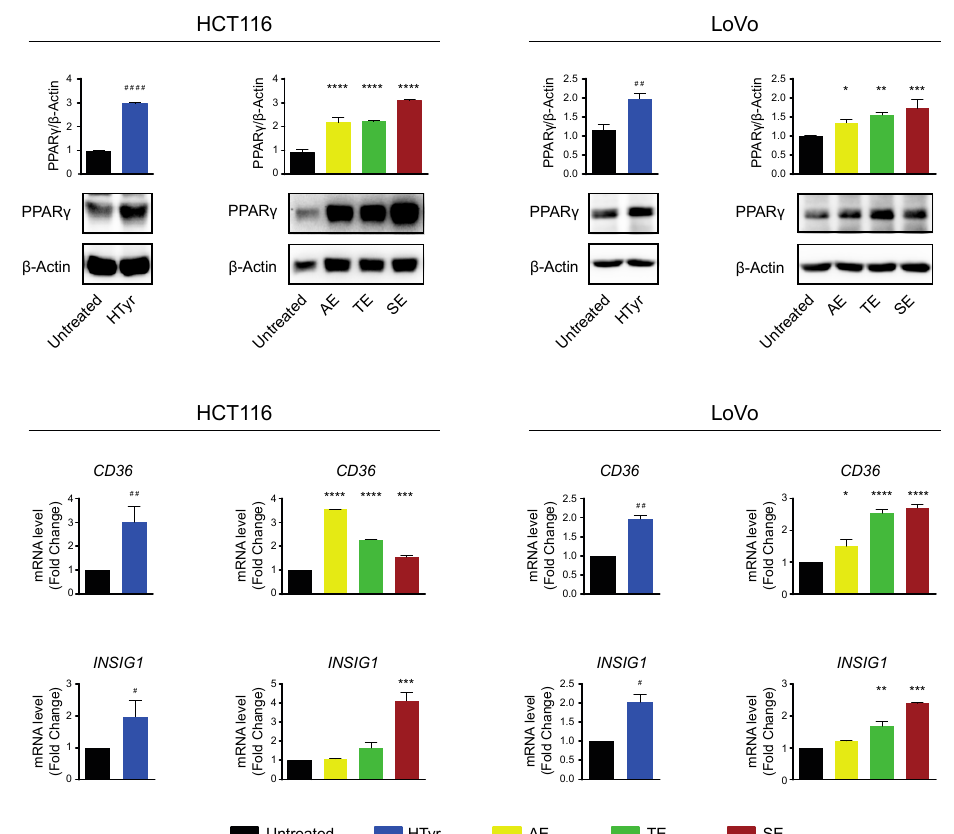
Figure 8. Hydroxytyrosol and the OPWPs extracts stimulate PPAR γ and its target genes in colorectal cancer cells: ( A ) Western blot analysis of PPAR γ in HCT116 and LoVo cells treated for 72 h with HTyr or the OPWPs extracts at the concentrations indicated in the text and compared to untreated cells. The histograms illustrate the ratio of PPAR γ to β -Actin used for normalization. ( B ) Quantitative real time PCR analysis of CD36 and INSIG1 mRNAs in cells treated for 72 h with HTyr or the OPWPs extracts at the concentrations indicated in the text and compared to untreated cells. Statistical significance is considered when # p ≤ 0.05, ## p ≤ 0.01, #### p ≤ 0.0001 ( t -test) or * p ≤ 0.05, ** p ≤ 0.01, *** p ≤ 0.001, **** p ≤ 0.0001 (ANOVA with Dunnett’s post-test).